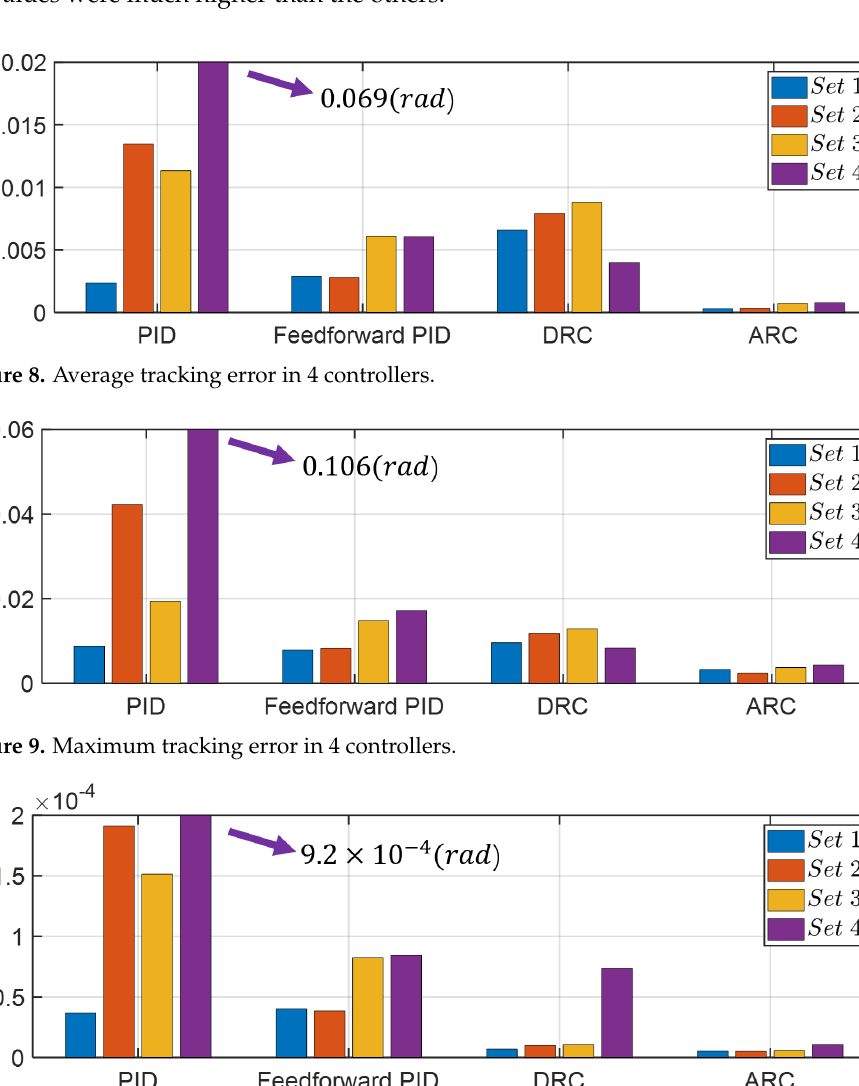
Figure 10. Standard deviation of tracking error in 4